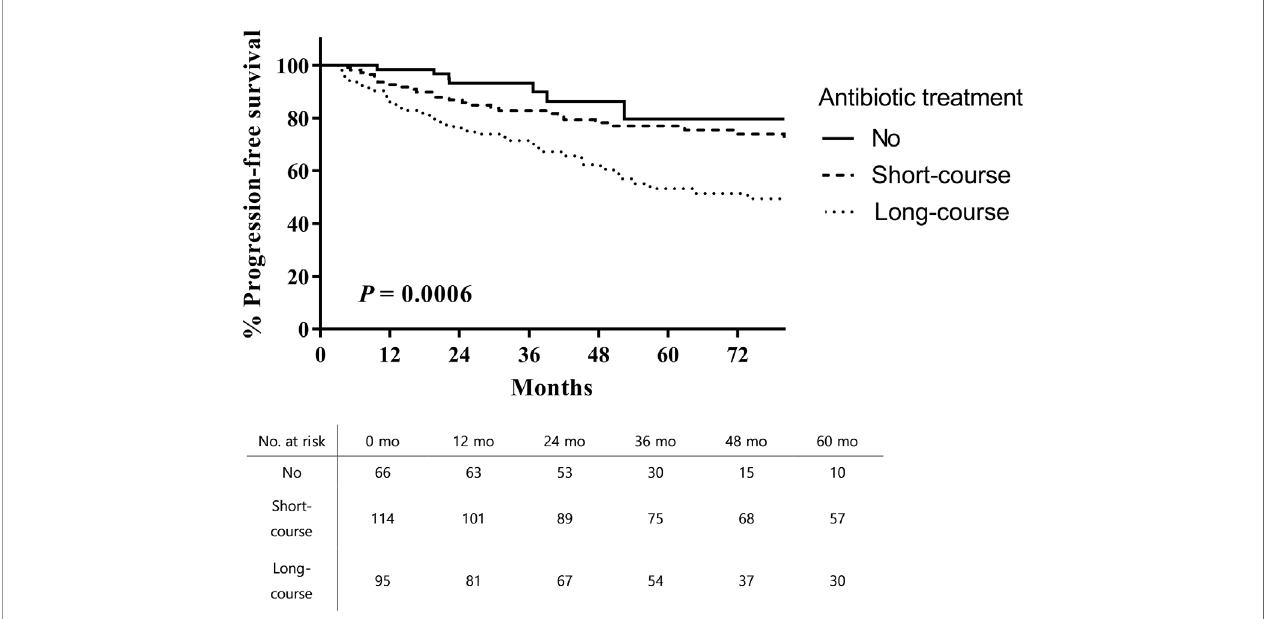
FIGURE 2 | Progression-free survival after intravesical BCG therapy in patients with high-risk non-muscle invasive bladder